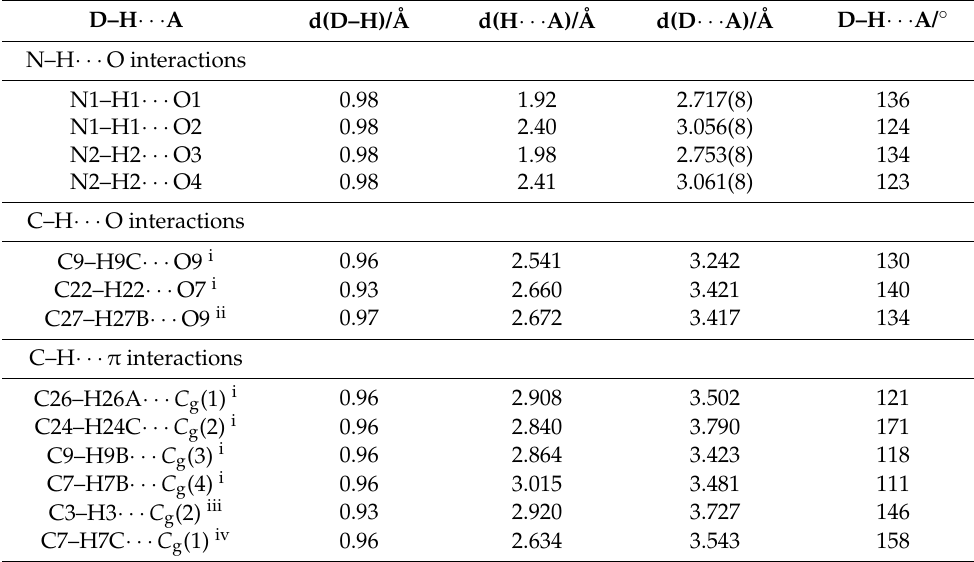
Table 2. Geometries of N–H · · · O, C–H · · · O, and C–H · · · π interactions (Å, ◦